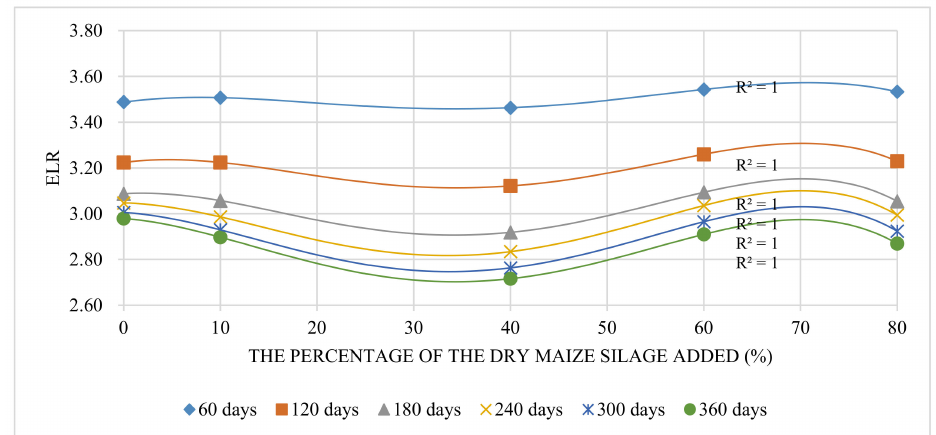
Figure 4. The trend of ELR change with different percentages of maize silage added.